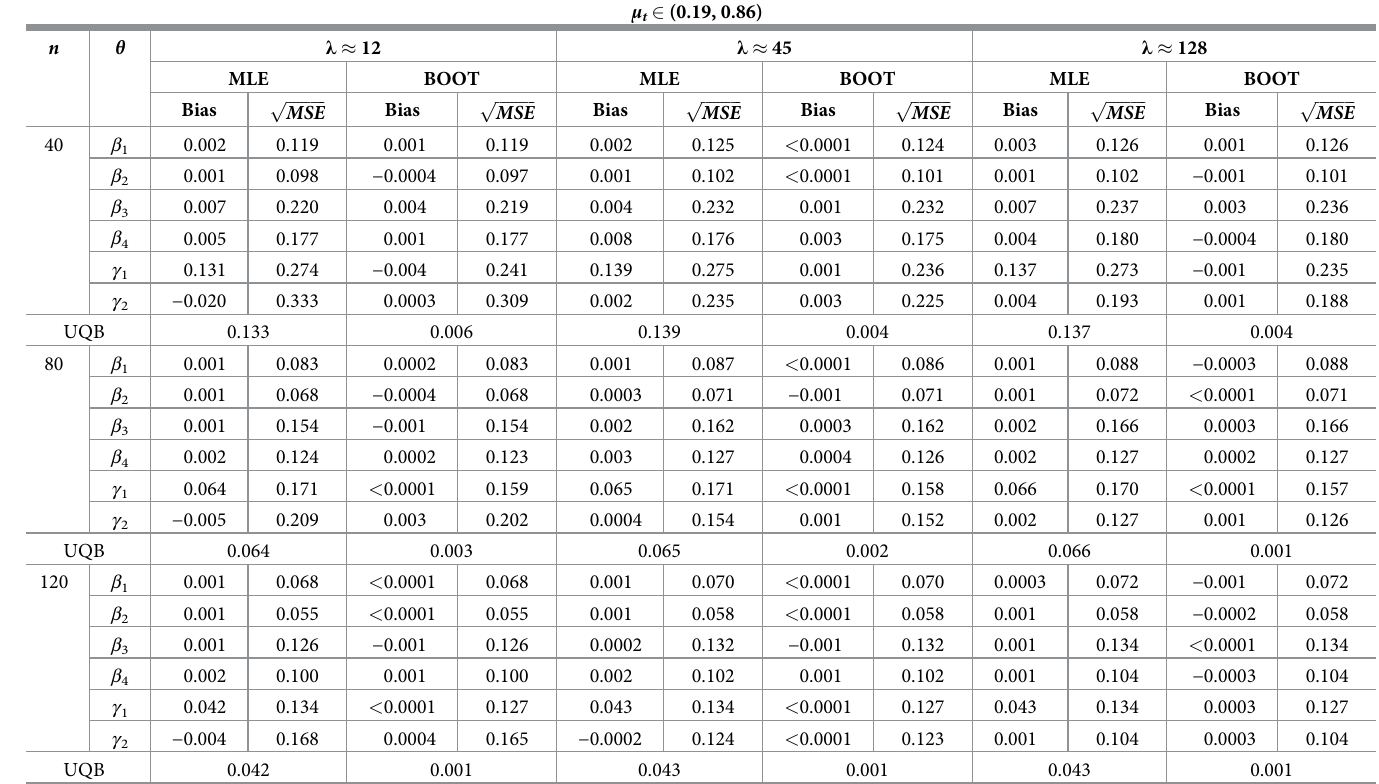
Table 2. Relative biases and root mean square errors of the Maximum Likelihood Estimators (MLEs) and bootstrap corrected MLEs of the model